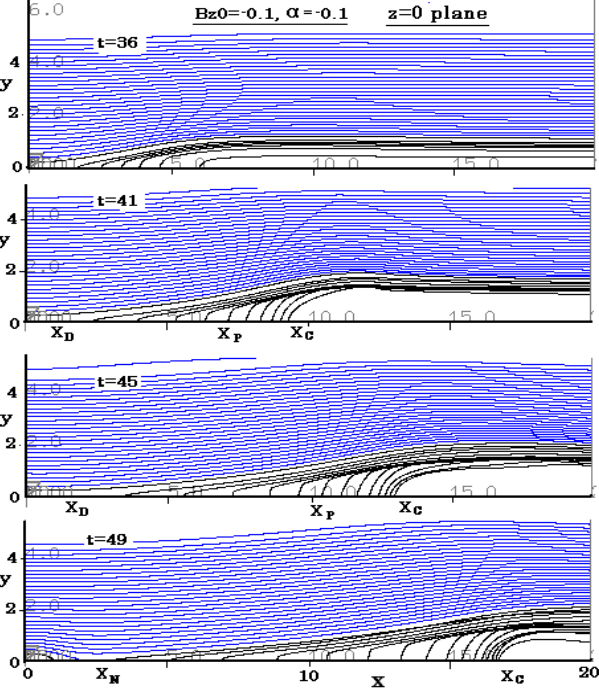
Fig. 5. Distributions of plasma pressure P with the contour interval Figure 5: Distributions of plasma pressure P with the of 0 . 15 in the z = 0 plane at different times for the case of B z 0 = − 0 . 1 and α =− 0 . 1. contour interval of 0 : 15 in the z = 0 plane at difierent times for the case of B z 0 = 0 : 1 and fi = 0 : 1. ¡ ¡